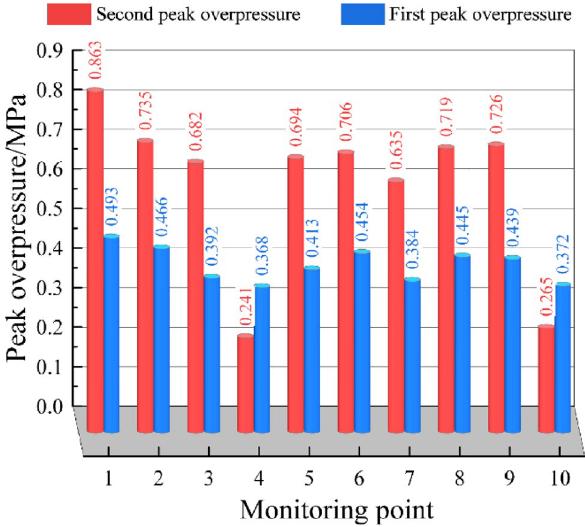
Figure 9. The first and second overpressure peaks at each monitoring point.